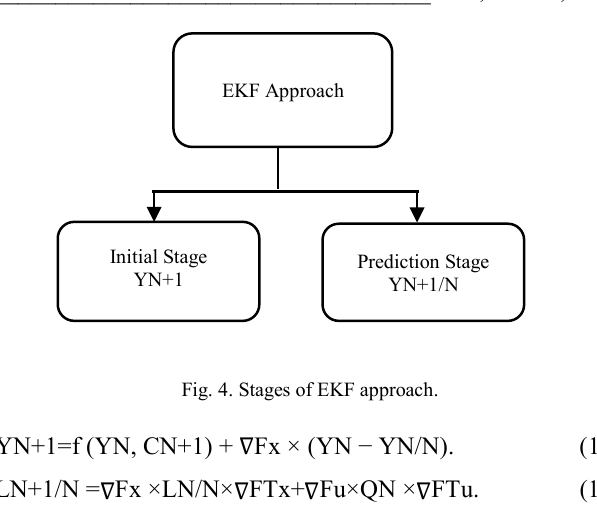
Fig. 4. Stages of EKF